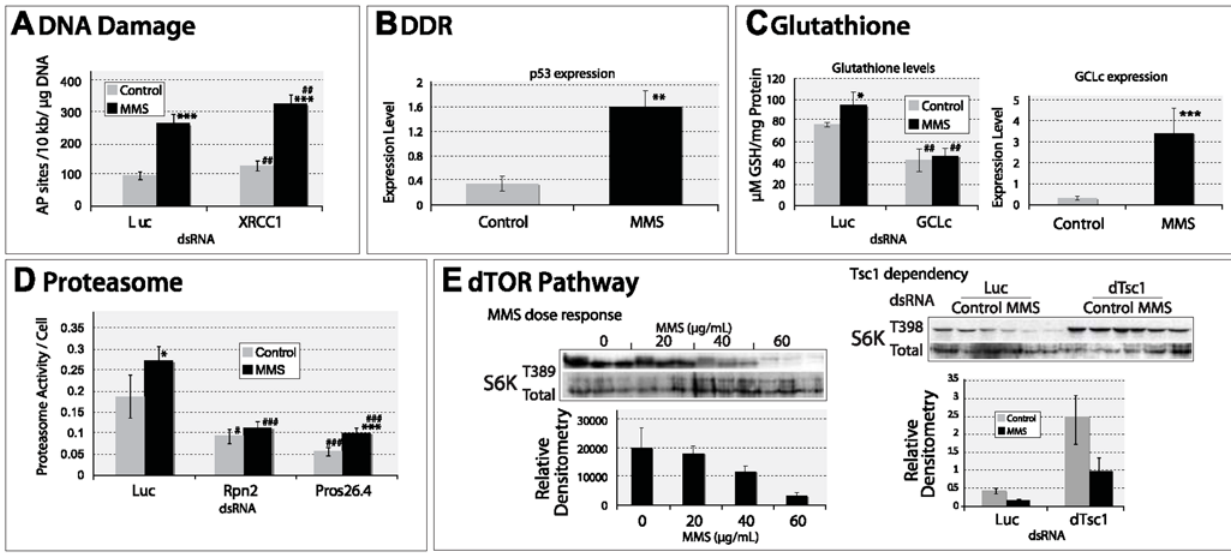
Figure 4. An examination of the functionality of five of pathways utilized in MMS survival by Drosophila cells. (A) MMS exposure results in an increase in AP sites. dsRNA knock-down of the BER component XRCC1 increases the quantity of AP sites observed following MMS exposure. (B) MMS exposure results in increased p53 expression by quantitative real-time PCR analysis; expression level is provided as fold change compared to an endogenous control (CG6905). (C) MMS results in an increased amount of total glutathione, and this increase is dependent upon the rate limiting glutathione metabolizing enzyme glutamate cysteine ligase (GCLc). The intracellular glutathione concentration is expressed as mmoles/L normalized per mg protein. This GCLc dependency correlates with the increased level of GCLc expression observed following MMS exposure. (D) Proteasome activity is increased following MMS exposure in a manner that is dependent upon proteasome components Rpn2 and Pros26.4. Proteasome activity is expressed as units of activity/cell, normalizing the activity to the number of cells using a parallel viability assessment. (E) MMS exposure results in a dose-dependent decrease in the phosphorylation of the dTor component p70S6K. This decrease is dependent upon the negative regulator of dTor, Tsc1. Statistically significant differences between unexposed and MMS exposed cells are denoted (*; **; ***; with p-values of , 0.05; , 0.01; and , 0.001 respectively) as are differences between Luc control and each dsRNA knock-down ( # ; ## ; ### ; with p-values of , 0.05; , 0.01; and , 0.001 respectively).